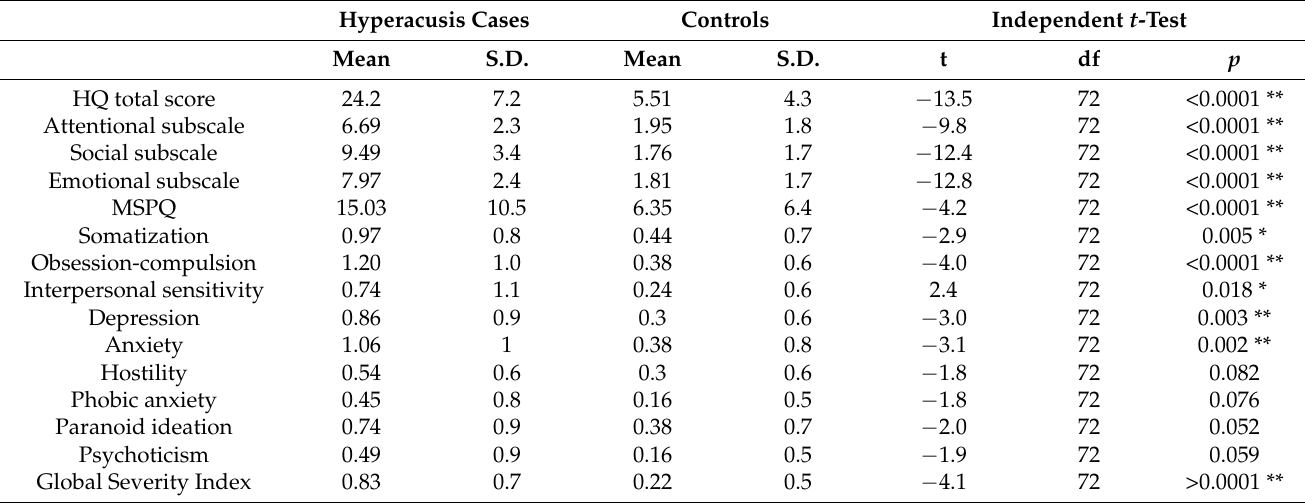
Table 4. Mean scores and standard deviation of HQ, MSPQ, and BSI. The significance level is reached for p values < 0.05 (*) and <0.005